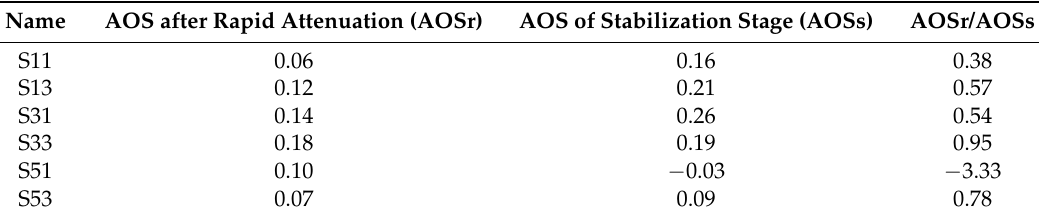
Table 2. The residual rate of the structure stress.